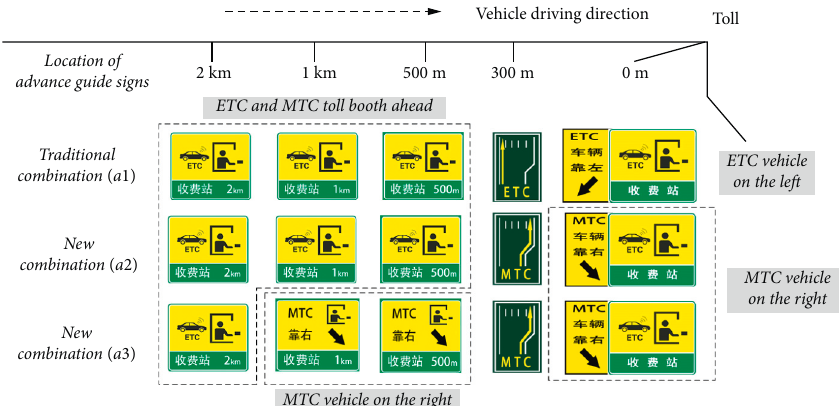
Figure 2: The three sign design